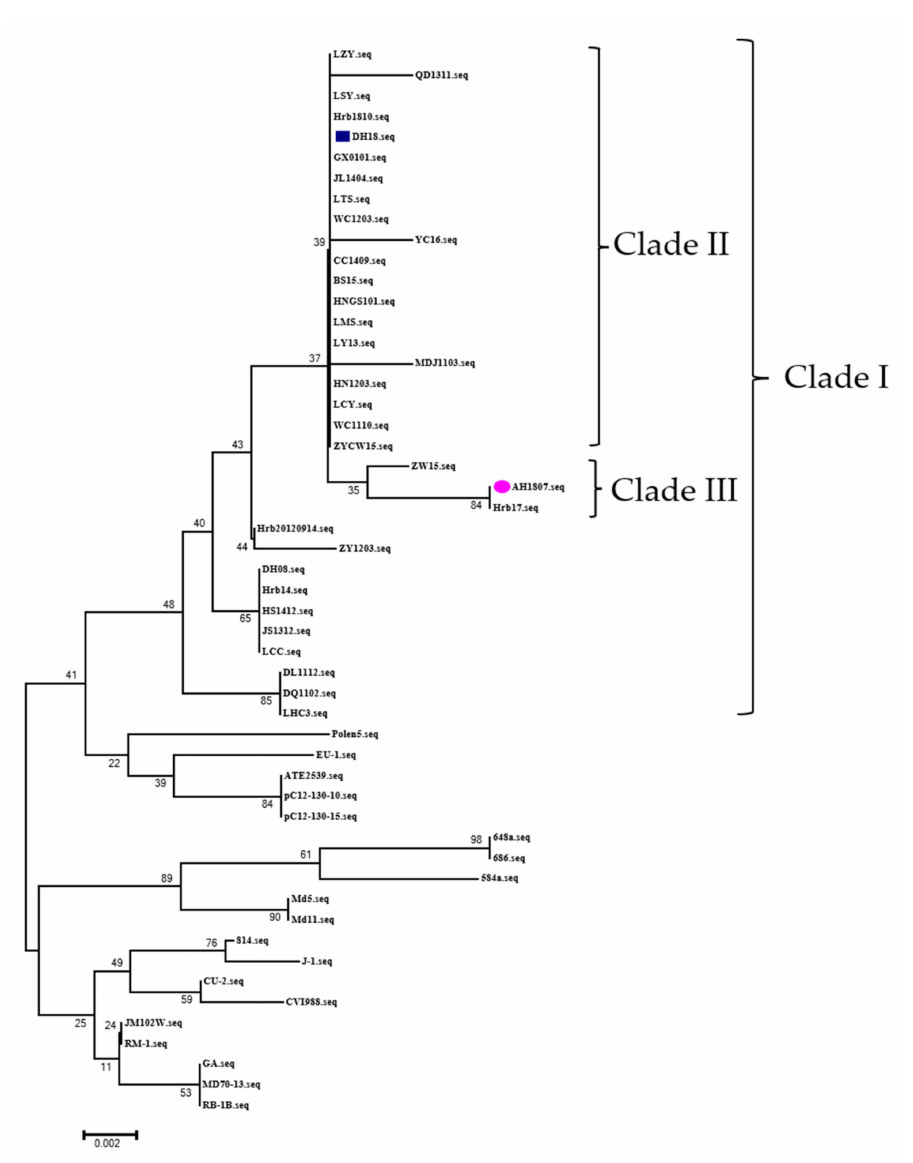
Figure 8. Phylogenetic tree based on meq gene complete amino acid sequences of AH/1807 and DH/18 that marked with a colored dot. Other strains were retrieved from